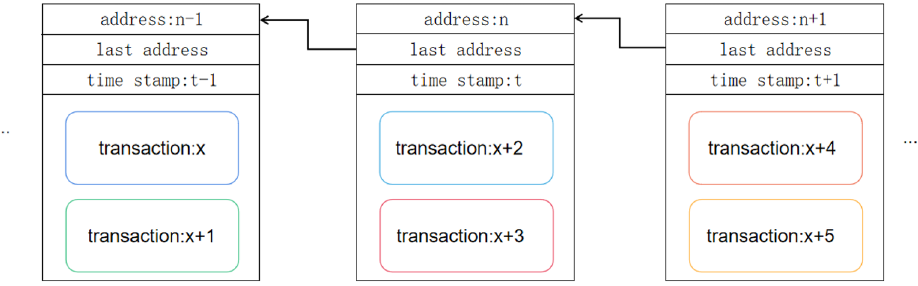
Figure 1. The data structure of the quantum blockchain. The block header contains the address of the current block, the address of the previous block and the timestamp. The block body contains the transaction that